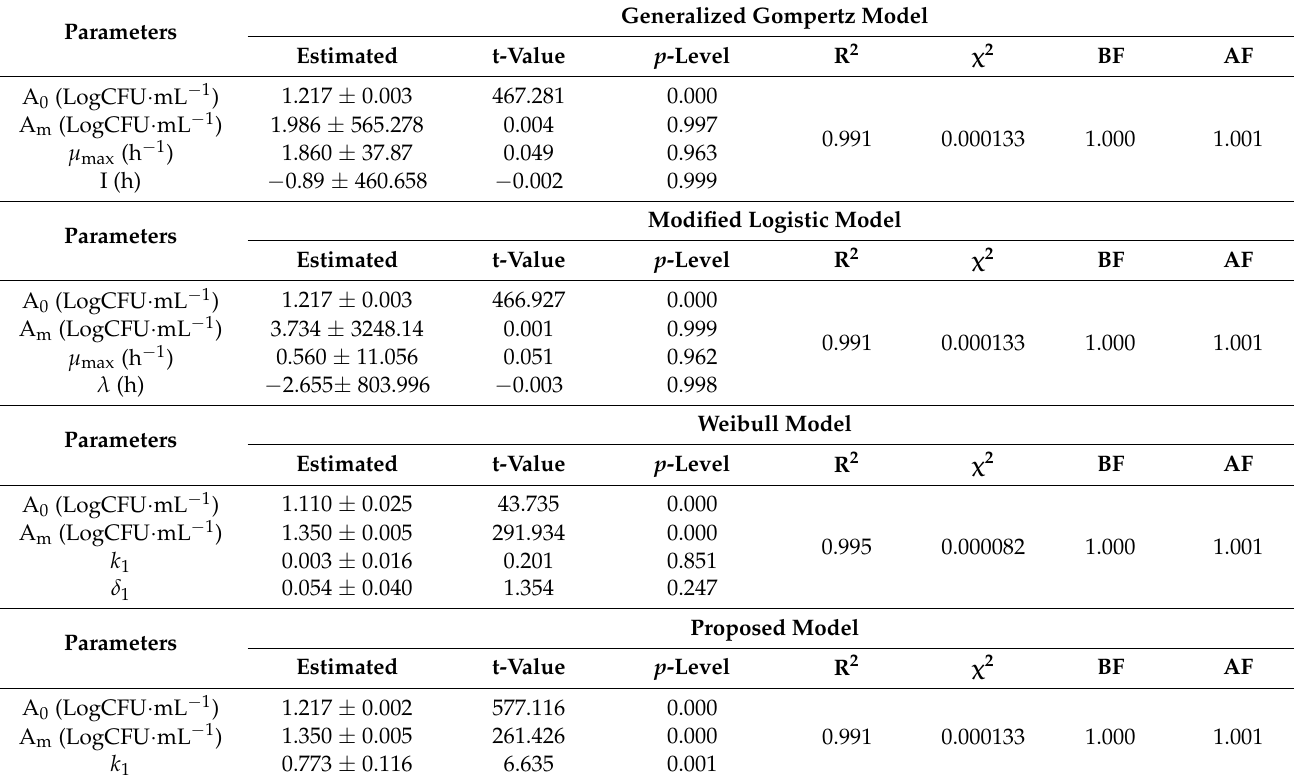
Table 5. Parameters of the models for the substrate consumption process in the filmogenic solution.